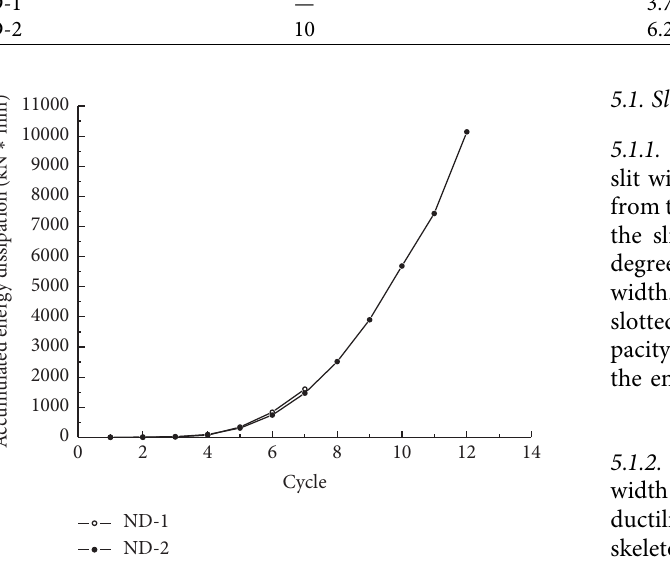
Figure 11: Accumulated energy